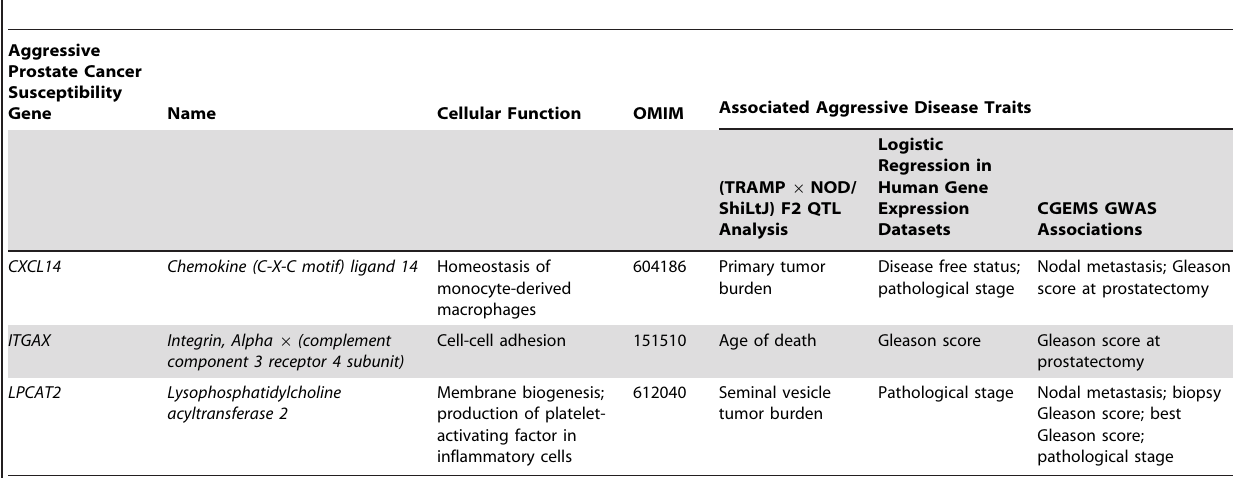
Table 6. High priority aggressive prostate cancer susceptibility genes and associated aggressive disease traits form each element of this